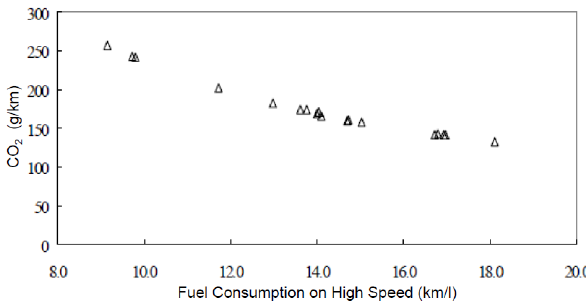
Figure 7. The fuel consumption vs . CO 2 emission on high speed. Source [39].